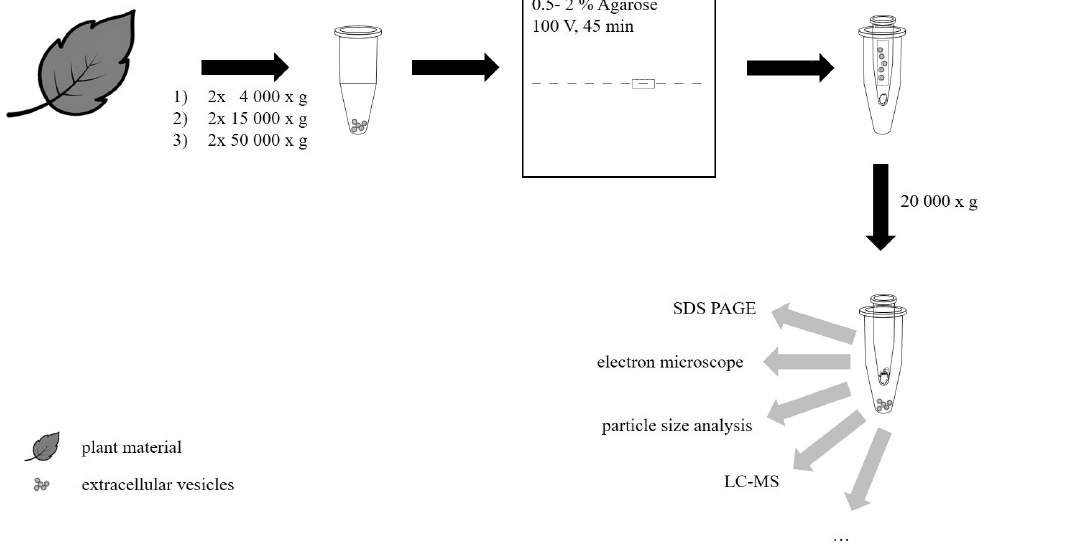
Figure 1. Workflow of PEV isolation, agarose gel electrophoresis, recovery, and possible further analysis (Note: Currently, we did perform SDS PAGE after agarose gel electrophoresis. Further